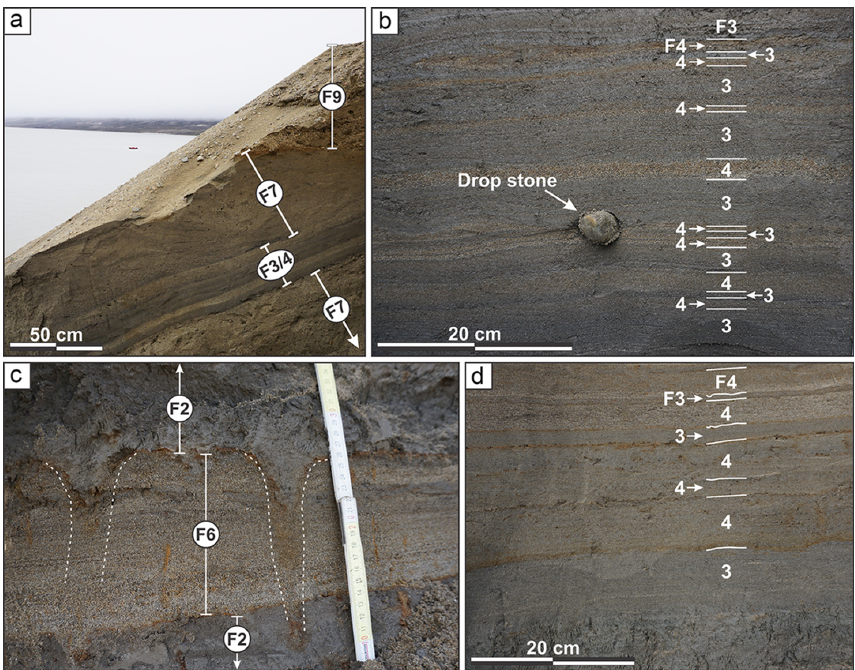
Figure 4. Fine-grained sedimentary facies. (a) Massive gravels (facies 9) truncating massive pebbly sand (facies 7), interbedded sands and silts (facies 3), and graded sands (facies 4) at S2 at 11ma.s.l. (b) Alternating facies 3 and facies 4 at S5 (9ma.s.l.). Note the presence of an outsized clast. (c) Bioturbated silts (facies 2) and laminated sands (facies 6) at S5 (6ma.s.l.). Note vertically oriented burrows outlined with white dashed lines. (d) Alternating facies 3 and facies 4 at S2